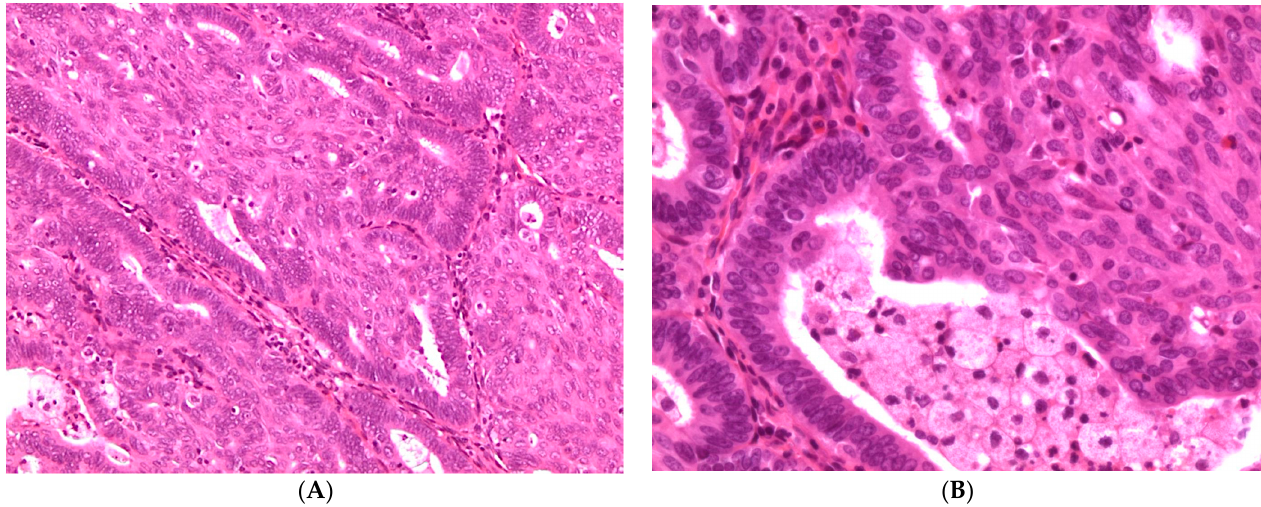
Figure 3. ( A ) and ( B ) Histologic appearance (hematoxylin and eosin, H&E) of low-grade endometrioid carcinoma with squamous differentiation (×100 and ×200, respectively).